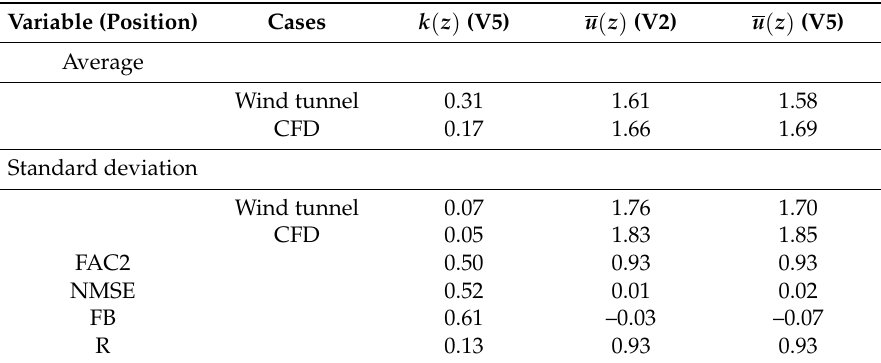
Table 2. Statistical performance metrics in CFD validation